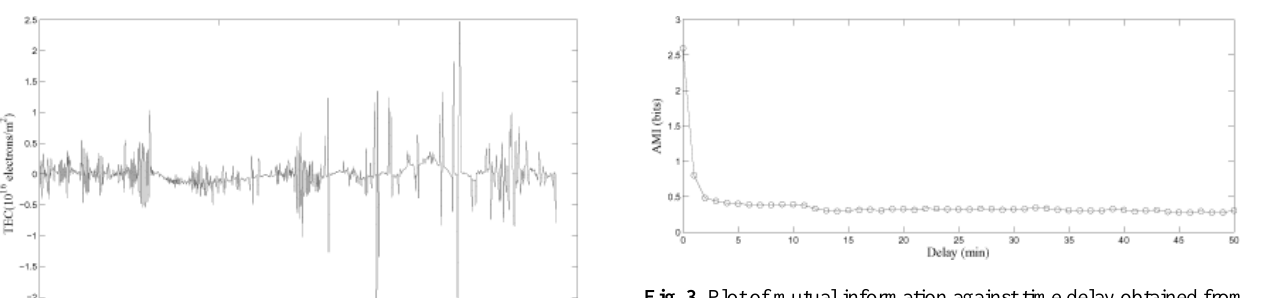
Fig. 3. Plot of mutual information against time delay obtained from the detrended TEC data measured from Lagos.